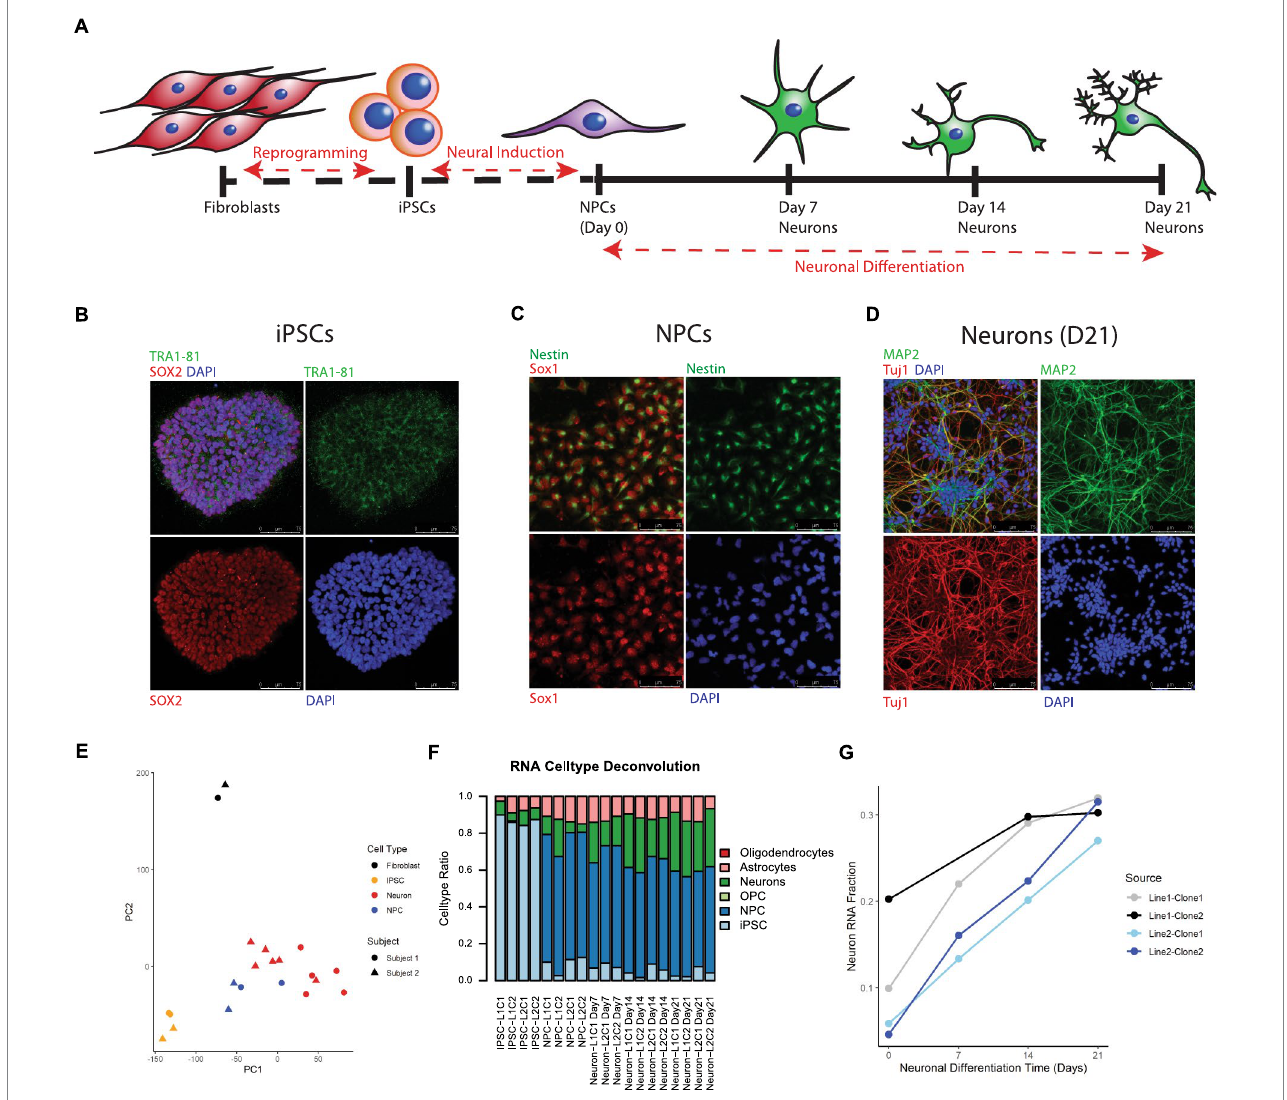
FIGURE 1 Differentiation and transcriptional characterization of cell lines. (A) Scheme of postmortem fibroblast reprogramming to iPSCs and differentiation to neurons. (B) Immunofluorescent (IF) staining of iPSC colonies for the stem cell markers TRA 1–81 (green), SOX2 (red), and DAPI (blue). (C) IF staining of NPCs for the NPC markers Nestin (green) and Sox1 (red). (D) IF staining of Day 21 neurons for the neuronal markers Map2 (green), Tuj1 (red) and DAPI (blue). (E) Principal Component Analysis (PCA) of RNA seq data, colors label cell type and shape label postmortem subject source. (F) Stacked barplot showing results of RNA cell type deconvolution. (G) Neuron RNA cell type fraction plotted against neuronal differentiation time, NPCs noted as time = 0. Color of plot line indicates cell line and clone